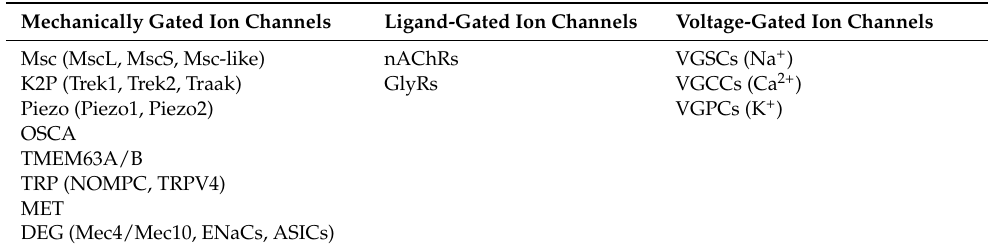
Table 1. Classification of ion channel